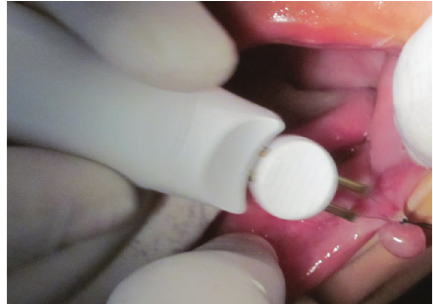
Figure 4: H&E stained section reveals stratified squamous epithe- lium with underlying connective tissue consisting of large central mucin pooled area surrounded by granulation tissue and chronic inflammatory